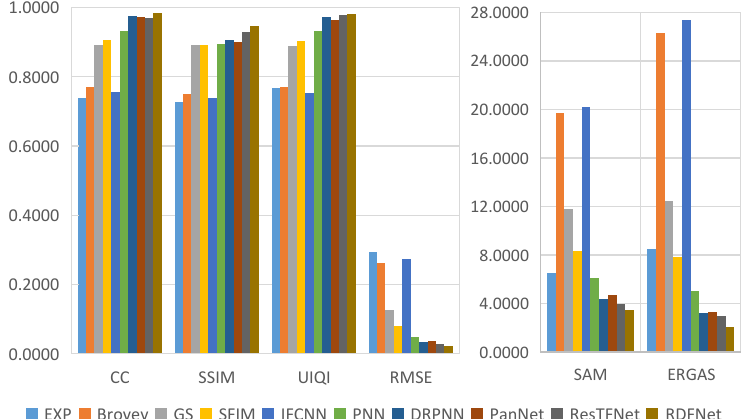
Figure 25. Quantitative metrics of testing dataset fusion results on Landsat-7 with reduced resolution.